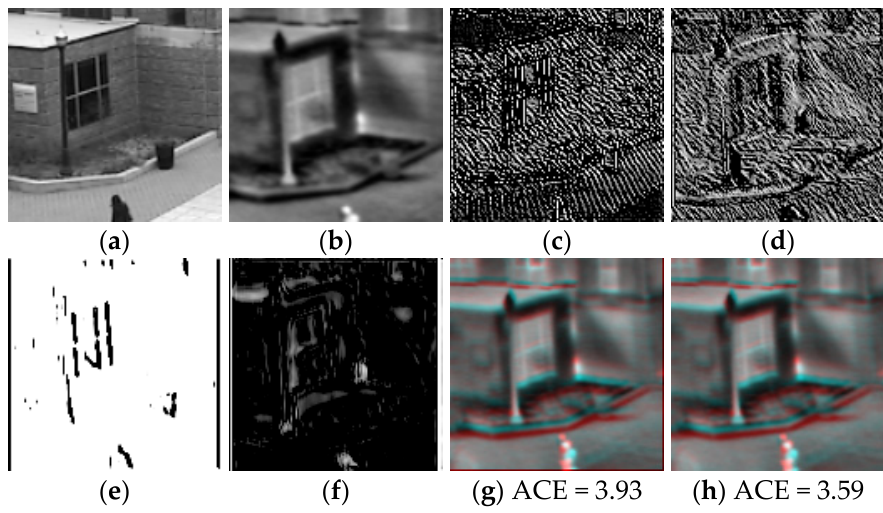
Figure 1. Homography estimation with the proposed method and a deep learning-based method (CADHN [15]). ( a , b ) represent the visible and infrared image patches, respectively. ( c , d ) represent the visible and infrared image feature maps obtained by the feature extractor and mask predictor in CADHN [15], respectively. ( e , f ) represent the visible and infrared image feature maps obtained by the shallow feature extraction network in the proposed method, respectively. ( g , h ) represents the channel mixing visualization method of CADHN [15] and the proposed method, respectively. The channel mixing approach is to mix the blue and green channels of the infrared warped image with the red channel of the infrared ground-truth image. The channel mixing results are mixed using uncropped image pairs of size 150 × 150, so the channel mixing images have more detailed information than visible and infrared image patches. Specifically, misaligned pixels appear as yellow, blue, red, or green ghosts, and the channel mixing visualization in the rest of this paper adopts this method.